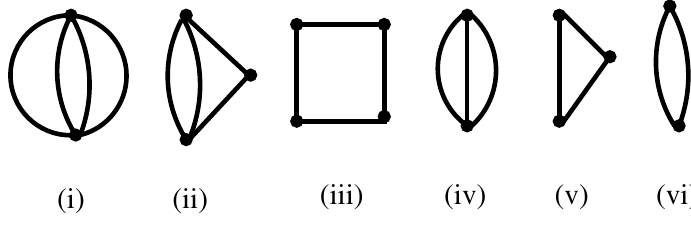
Figure 3 . The elliptic modular graphs (i) G ( v ) , (ii) G 2 ( v ) , (iii) G 3 ( v ) , (iv) D (1) D (1) ( v ) , (vii) D (2) ( v ) , (viii) D (1 , 2) 4 4 4